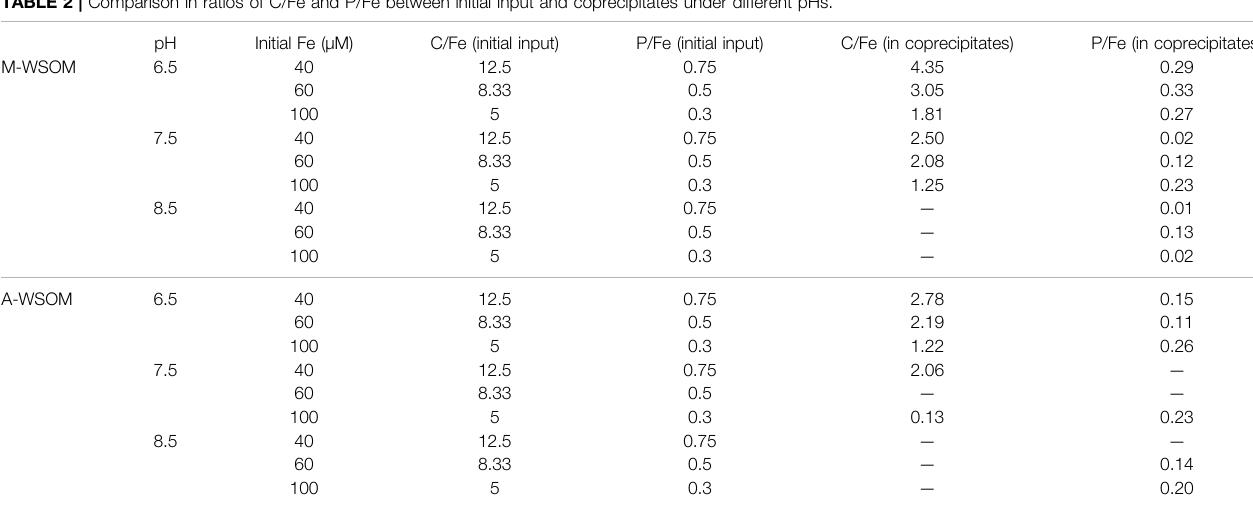
TABLE 2 | Comparison in ratios of C/Fe and P/Fe between initial input and coprecipitates under different pHs. pH Initial Fe ( μ M) C/Fe (initial input) P/Fe (initial